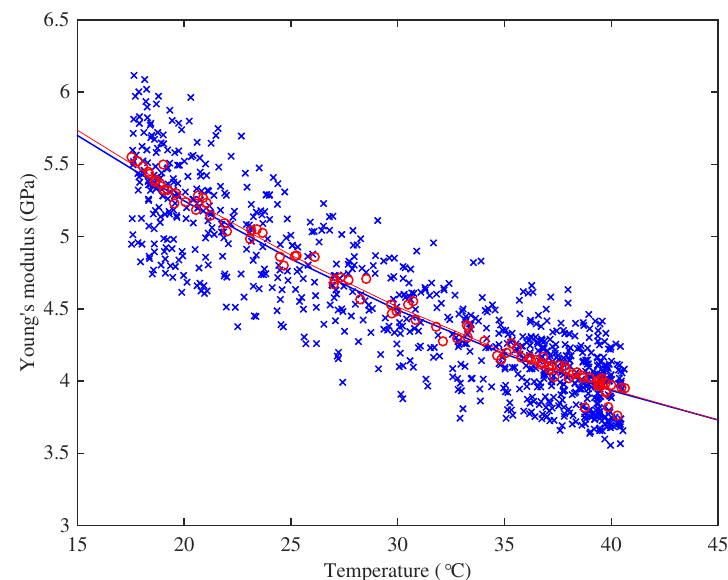
Figure 3. The Young’s modulus versus temperature responses obtained using tension modulation during the testing of String 23a (A3) at 323 Hz. The individual data points (blue crosses) show Young’s modulus values obtained for each individual tension step, after the steps with outsized length adjustments had been excluded. The red circles show the results obtained from the full-slope analysis. The corresponding fitted quadratics are also shown: they are almost identical, so they are hard to distinguish in the